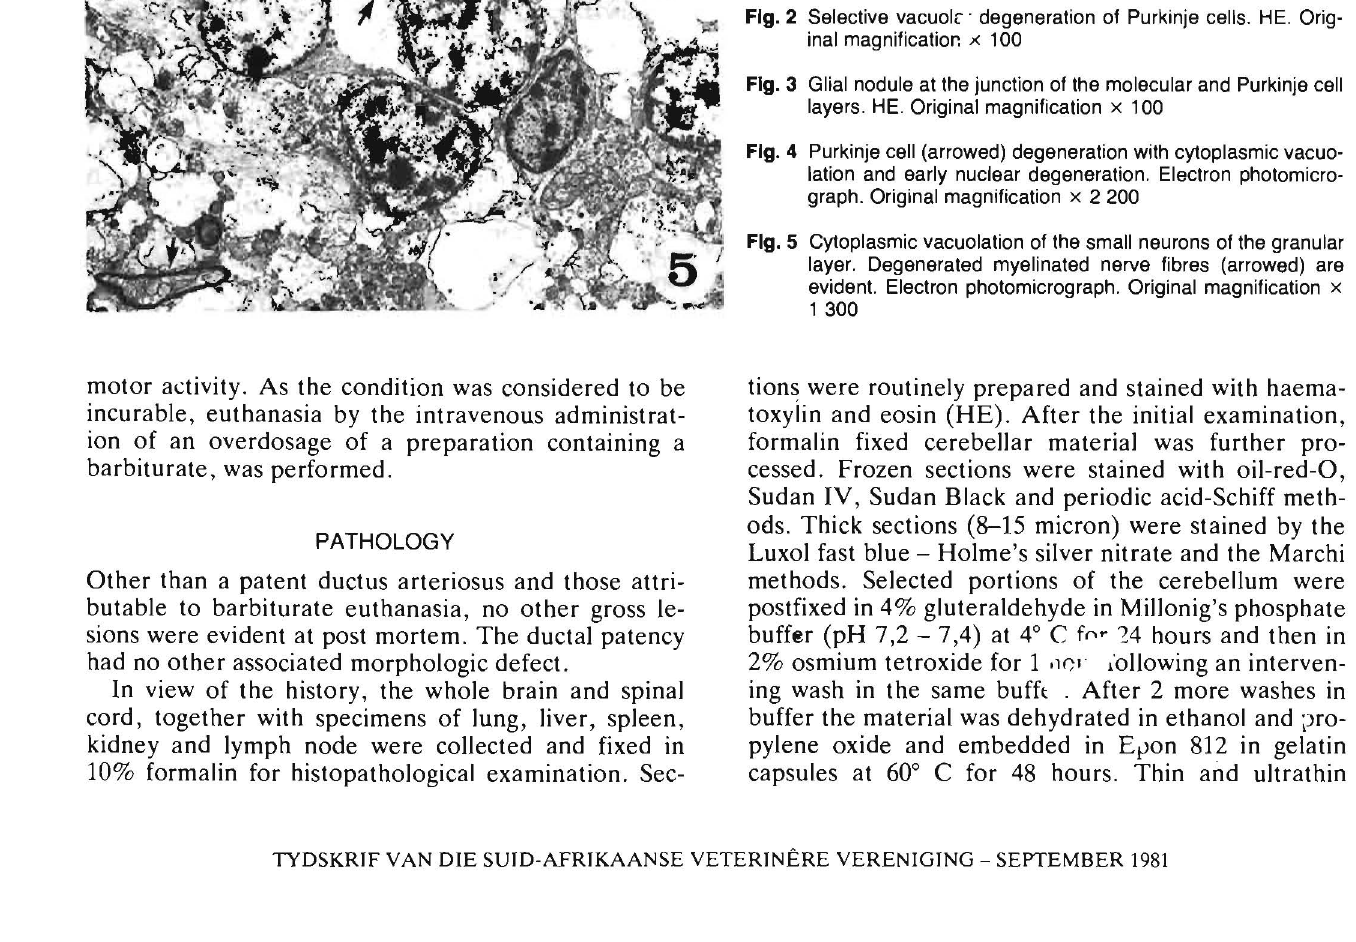
Fig. 2 Selective vacuolr' degeneration of Purkinje cells. HE. Orig inal magnificatior. )( 100 Fig. 3 Glial nodule at the junction of the molecular and Purkinje cell layers. HE. Original magnification x 100 Fig. 4 Purkinje cell (arrowed) degeneration with cy10plasmic vacuo lation and early nuclear degeneration. Electron photomicro graph. Original magnification x 2 200 Fig. 5 Cy10plasmic vacuolation of the small neurons of the granular layer. Degenerated myelinated nerve fibres (arrowed)